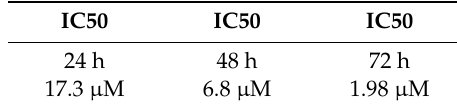
Table 1. IC 50 values calculated after 24, 48, and 72 h of treatment with Si306 on U87 glioblastoma cell